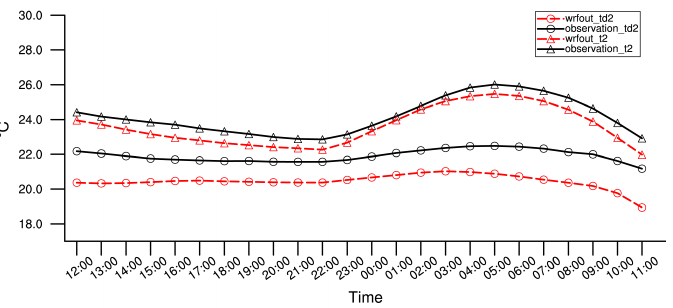
Figure A5. The comparison of the station observation ( a ) and WRF results ( b ) of 2-m dew point temperature ( ◦ C) during 12:00 UTC-11:00 UTC. ( c ) presents the bias of WRF model.